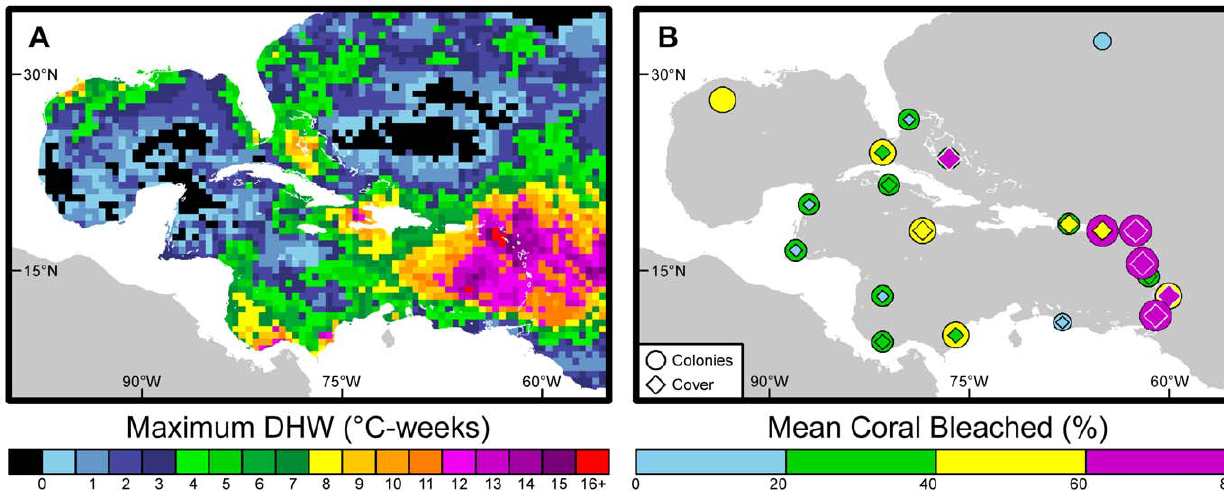
Figure 1. Thermal stress and bleaching during the 2005 Caribbean bleaching event. (A) Maximum NOAA Coral Reef Watch Degree Heating Week (DHW) values showing the highest thermal stress recorded at each 0.5-degree pixel during 2005. Values $ 4 u C-weeks typically resulted in significant bleaching; $ 8 u C-weeks typically resulted in widespread bleaching and significant mortality. (B) Jurisdictional means of coral bleached; marker color and size denote the severity measured as either percent live coral colonies (circles) or cover (diamonds).